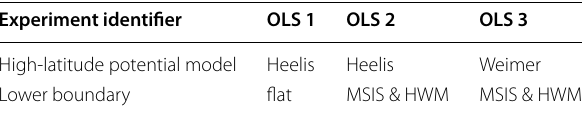
Table 2 Setup for open-loop simulations. Only settings that